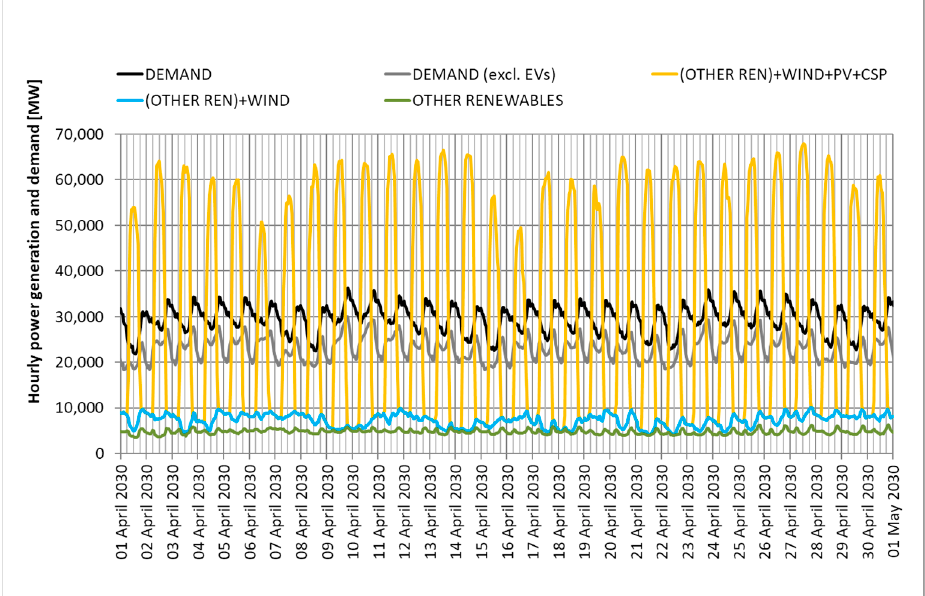
Figure 4. Projected hourly electricity demand and potential generation (i.e., pre-curtailment and storage) for the month of April 2030, in the “High BEV” scenario.